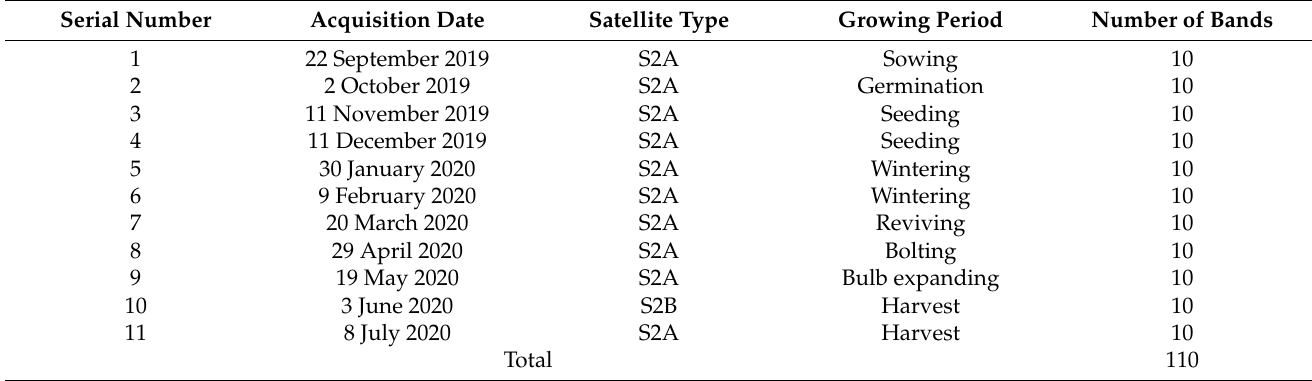
Table 1. Summary of Sentinel-2 images used in this study.